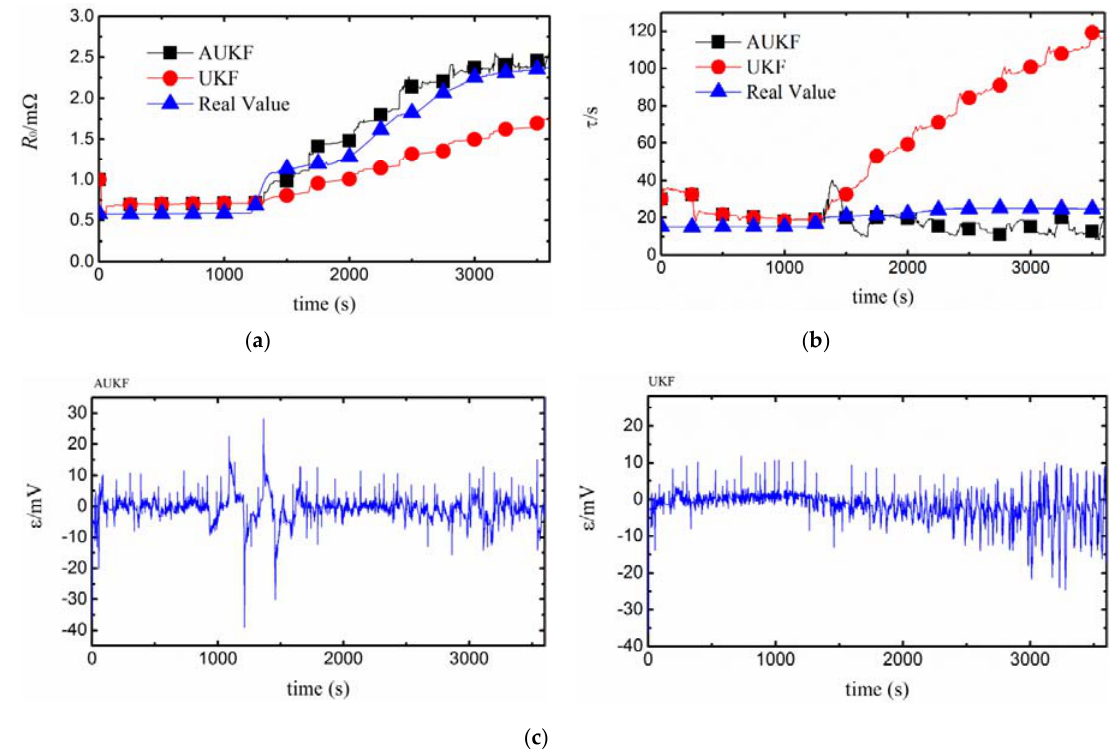
Figure 10. Estimation results of parameter abrupt-type fault. ( a ) Comparison of estimated ohmic resistance; ( b ) Comparison of estimated time constant; ( c ) Comparison of voltage residual.